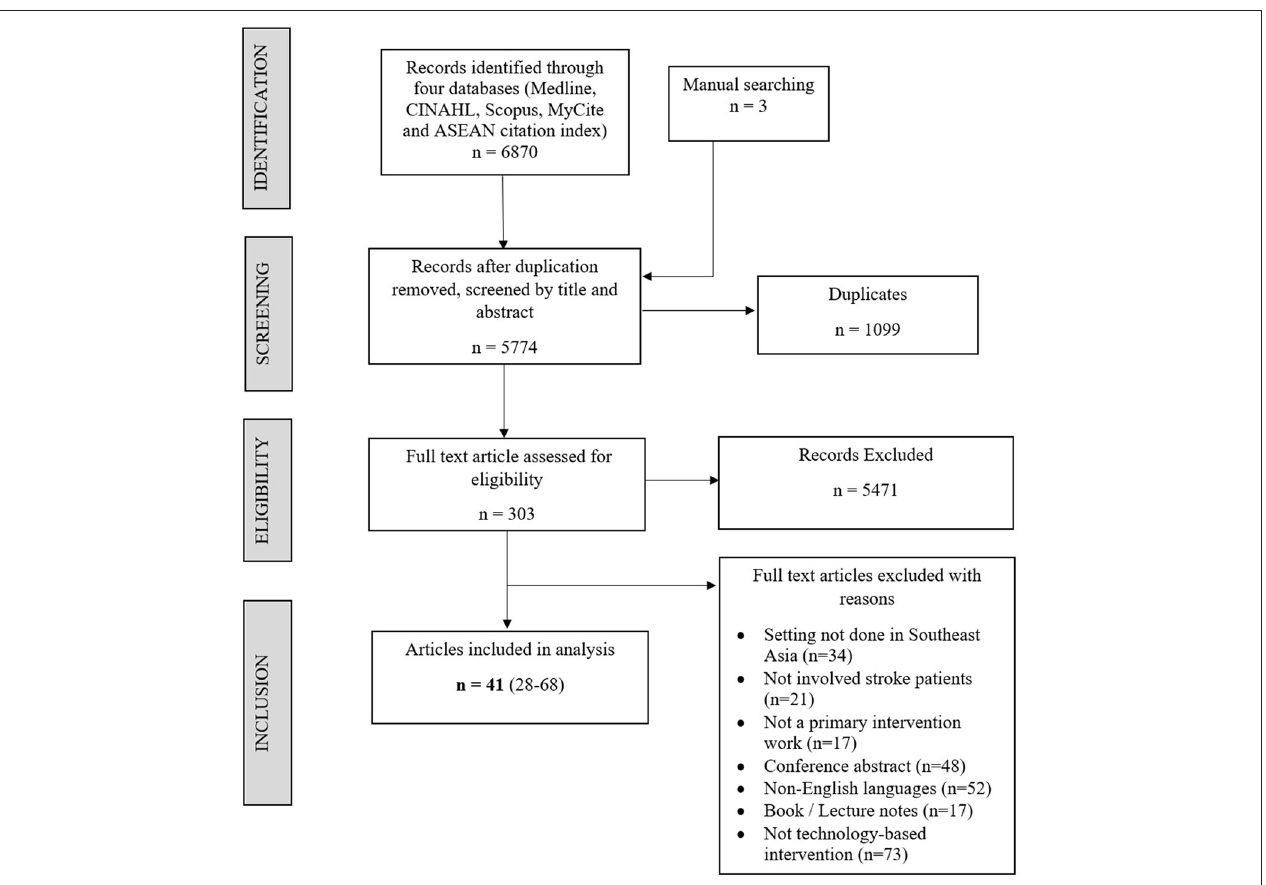
FIGURE 1 | Screening process